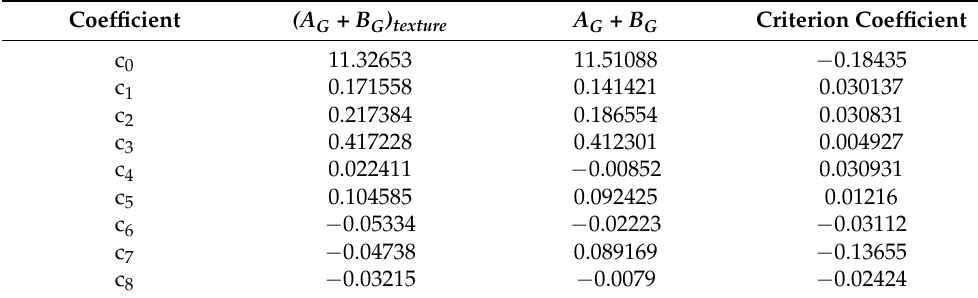
Table 10. The vector of the functional magnitude coefficients.